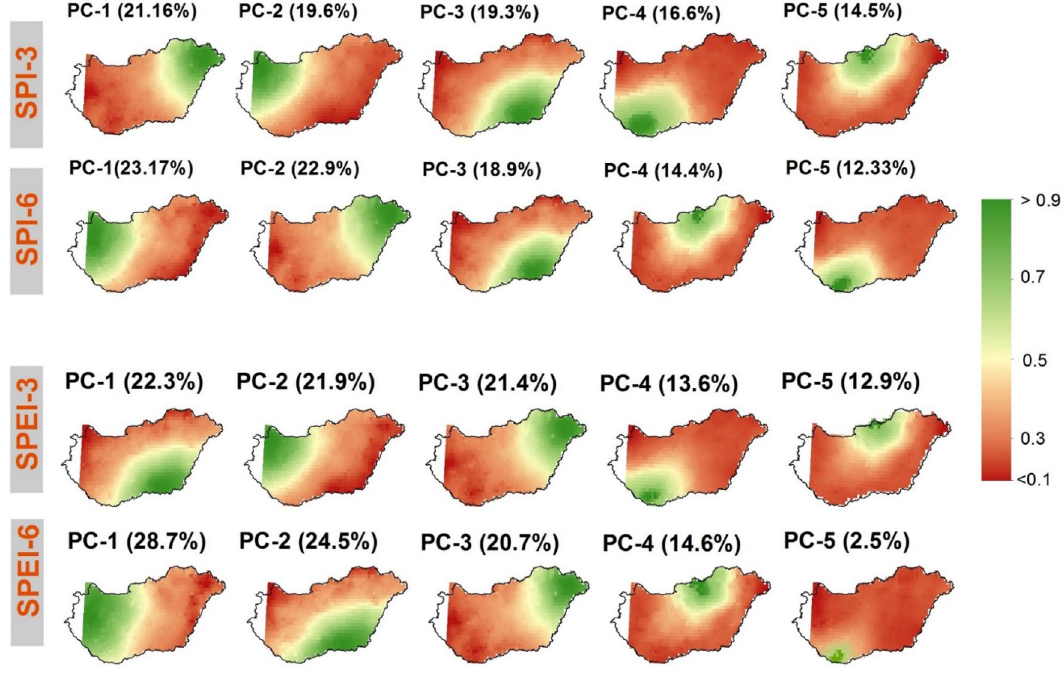
Figure 4. SPI-3, -6 and the SPEI-3, -6 relative to Varimax rotated loadings for the studied points (maps were generated using ArcGIS 10.8 (https:// www. esri. com/ en- us/ about/ about- esri/ overv iew)).